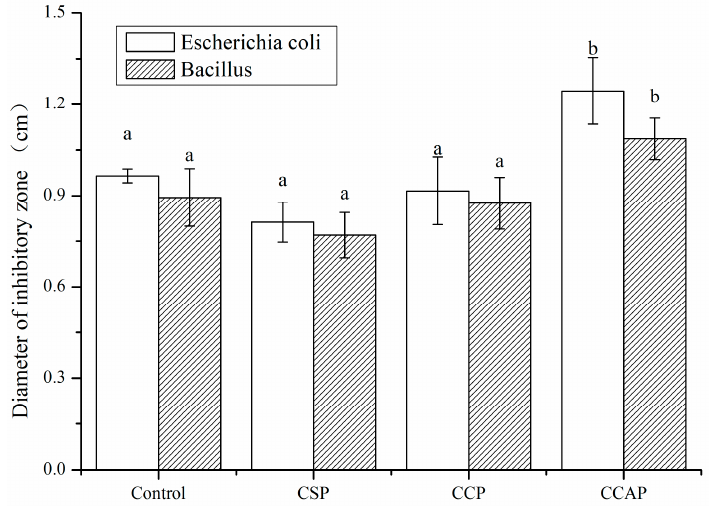
Figure 9. Antibacterial activity of chitosan (control) and peptide − containing films. CSP: films from chitosan and soy protein peptides; CCP: films from chitosan and corn protein peptides; CCAP: films from chitosan and casein peptides. Results having di ff erent letters (a,b) in same pattern are significantly di ff erent ( p < 0.05).